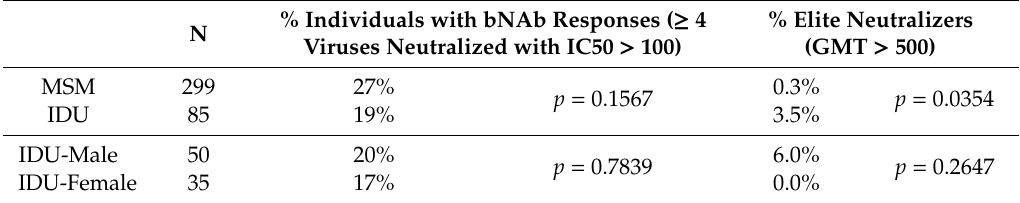
Table 1. Prevalence of broadly neutralizing antibody responses in HIV-1 infected MSM and IDUs. % Individuals with bNAb Responses ( ≥ 4 N